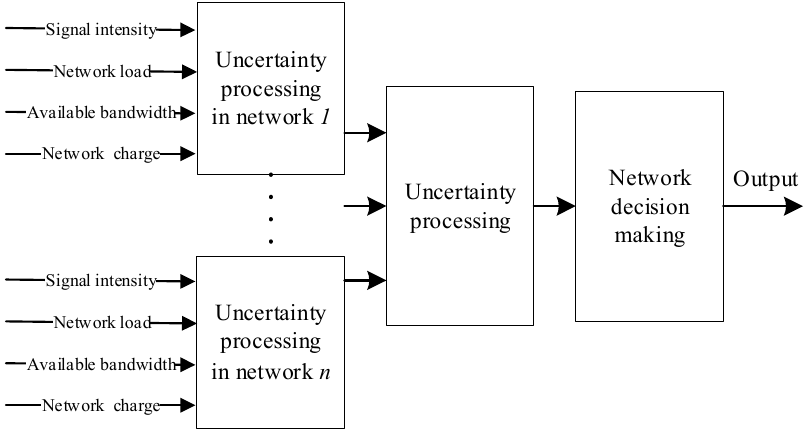
Figure 3. The uncertainty membership processing procedures.